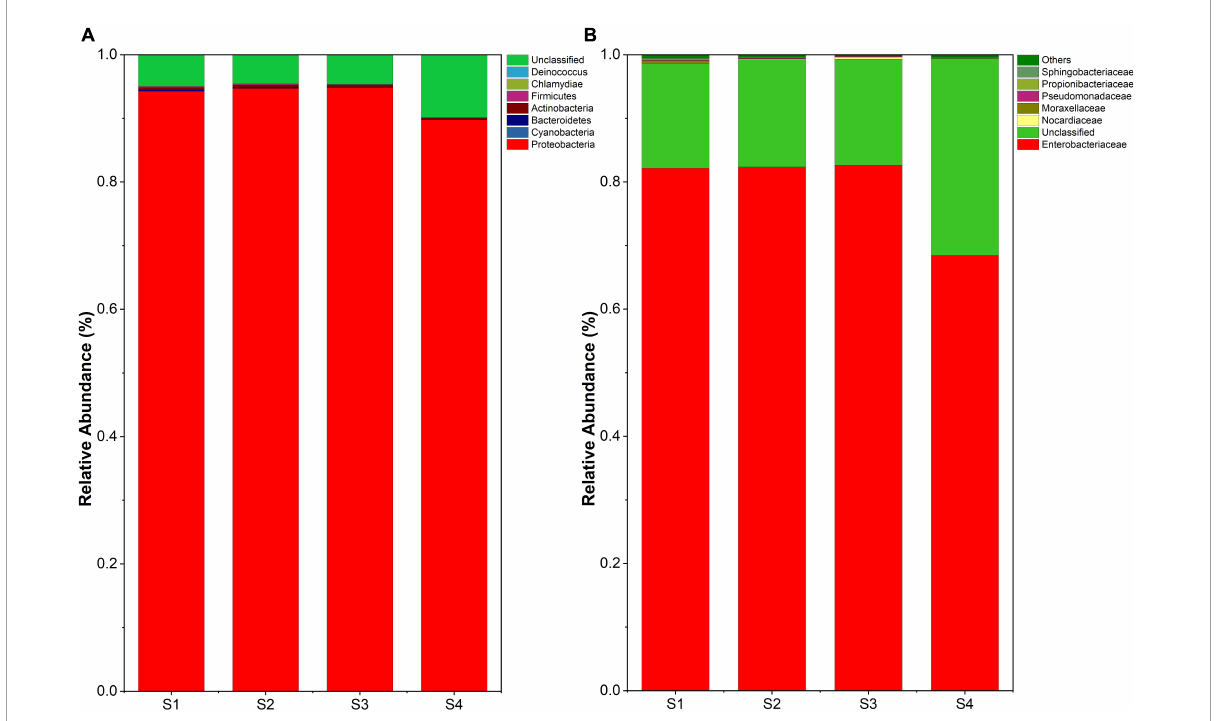
(including photosynthesis - antenna proteins, photosynthesis proteins, carbon fixation in photosynthetic organisms and photosynthesis) and flavonoids biosynthesis (consisting of phenylalanine, tyrosine and tryptophan biosynthesis,